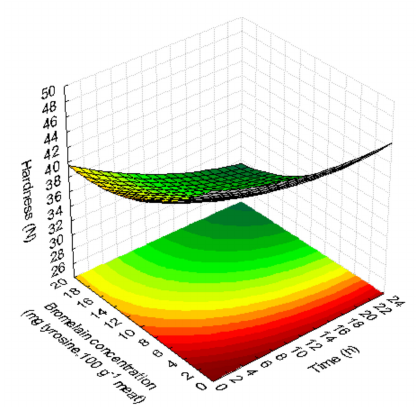
Figure 4. Response surface fitted for hardness as a function of marinades (bromelain concentration (mg tyrosine.100 g − 1 meat) and time